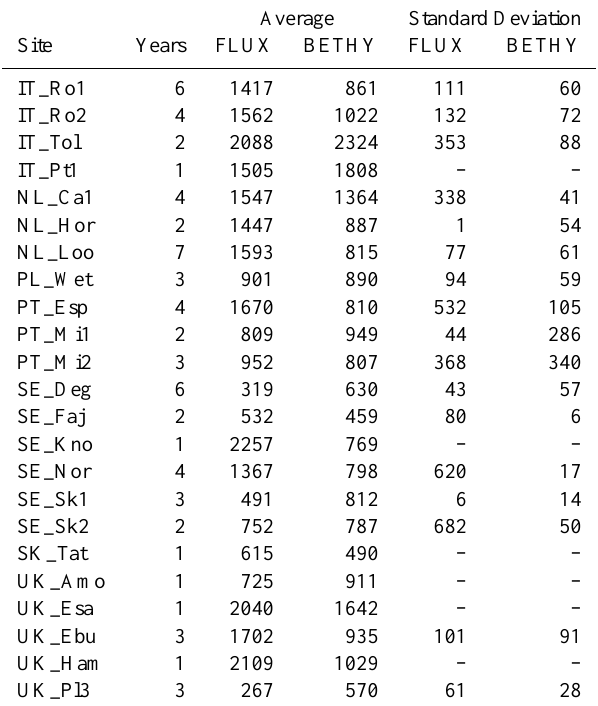
Table 5. Average GPP values for the 2000–2007 period and corre- sponding standard deviation for all 74 tower sites in gCm − 2 a − 1